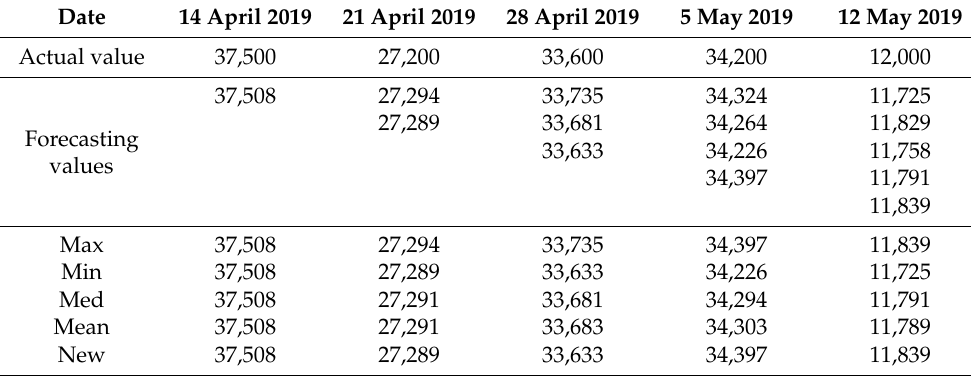
Table 2. BGA 11.5X13 error calculation results of each indicator.